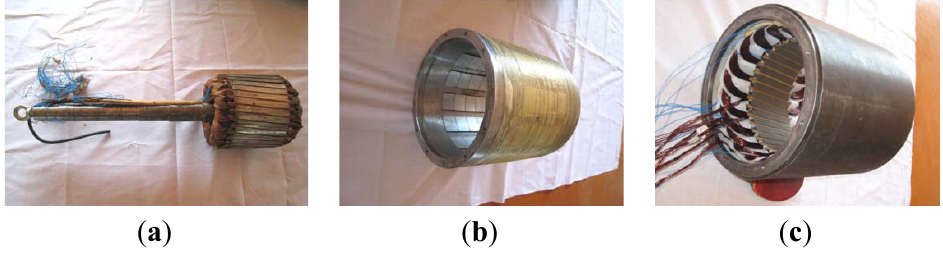
Figure 29. Main components of the CS-PMSM prototype: ( a ) inner rotor; ( b ) outer rotor; and ( c )